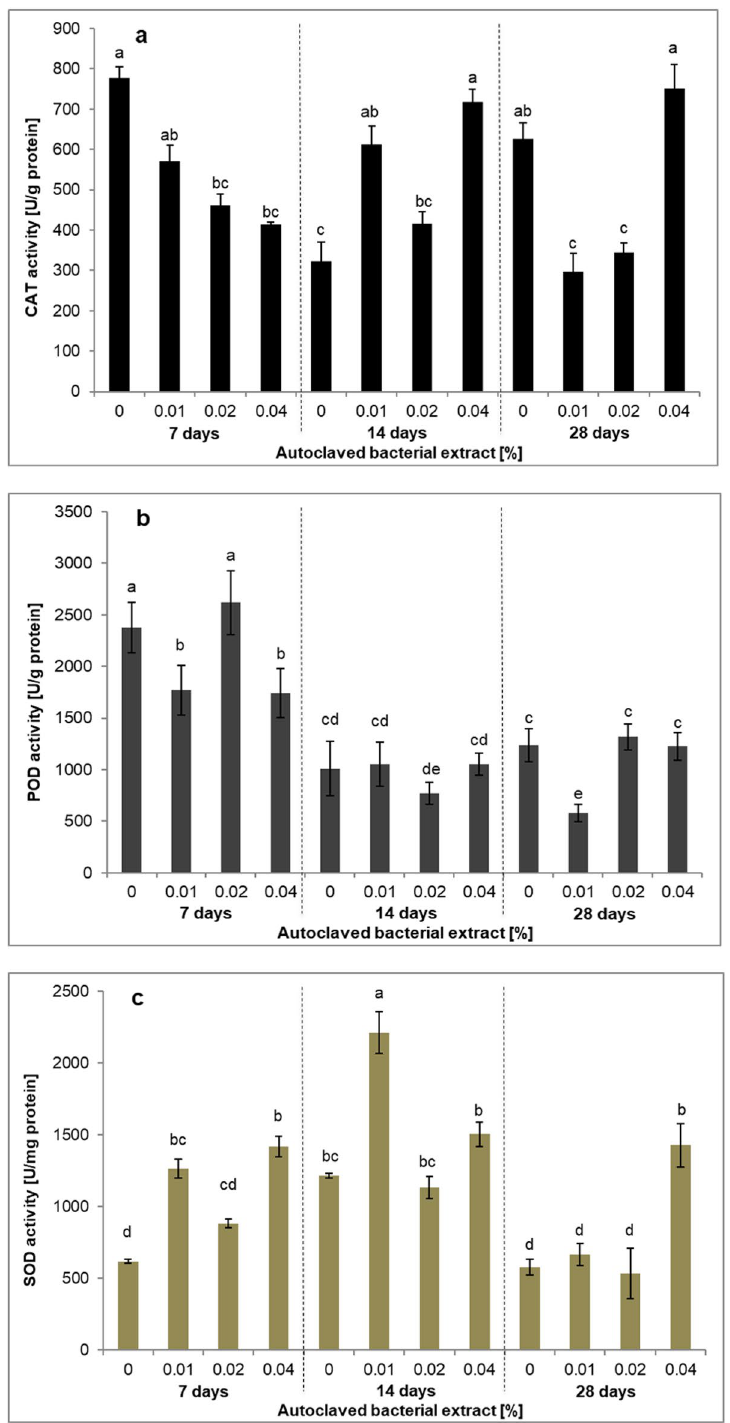
Figure 4. Effect of Paenibacillus lautus strain PLV elicitation on ( a ) CAT (catalase), ( b ) POD (peroxidase) and ( c ) SOD (superoxide dismutase) activity in L. aestivum in vitro plants. The results are means of three replicates (n = 3). Error bars represent ± SD. Different letters indicate a significance difference at P < 0.05 according to ANOVA and Duncan’s